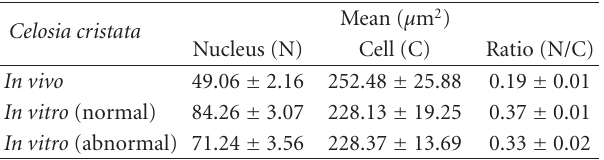
Table 3: The mean nuclear and cell areas and their ratios in root meristem cells of in vivo and in vitro grown Celosia cristata plants. Celosia